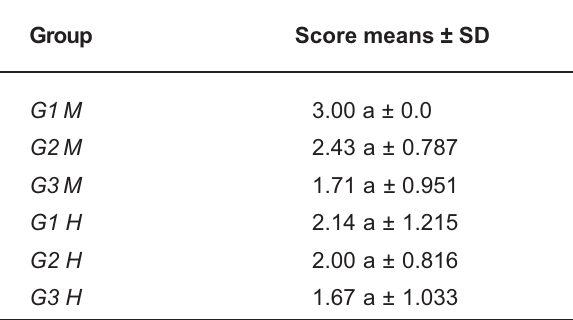
Different letters indicate statistically significant difference at